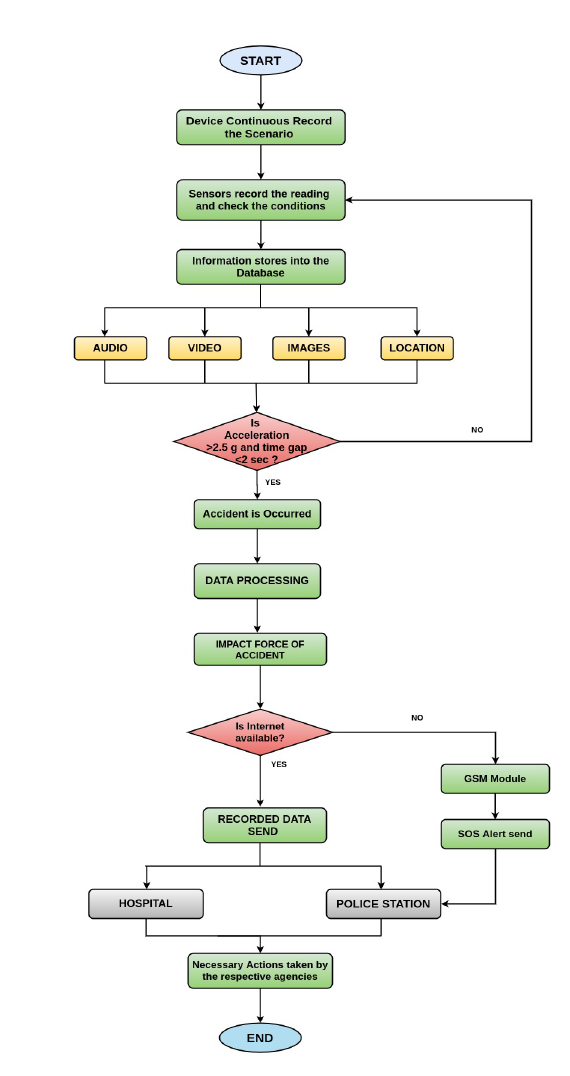
Figure 10. Flow chart of proposed algorithm